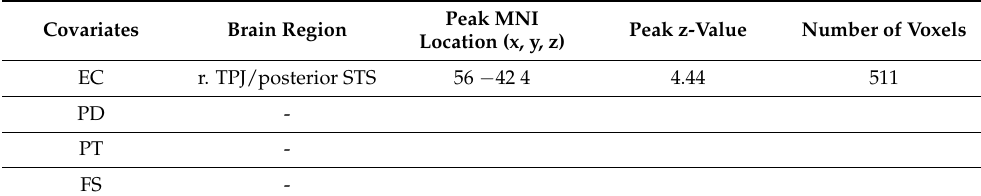
Table 3. Results of the contrast of brain responses during prosocial relative to selfish acting ( p < 0.05, Table 4. Results of individual scores of the IRI subscales as covariates of interest for parametric FWE corrected).